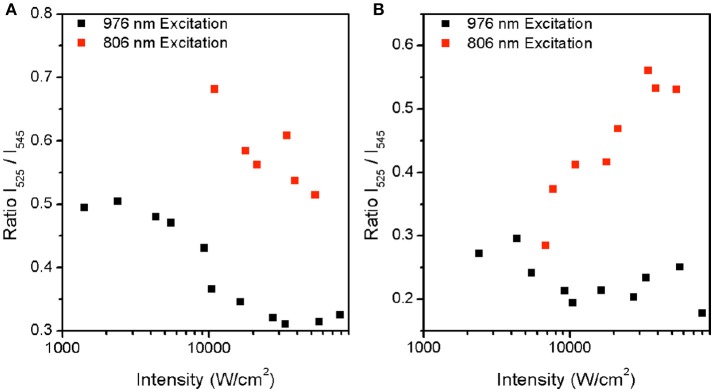
Plot of measured ratio between 2H11/2 and 4S3/2 at increasing intensity for both 806 nm and 976 nm excitation for (A) β-NaYF4:20%Yb, 2% Er (A) and (B) β-NaYF4:40%Yb, 2%Er@NaYF4:20%Yb@NaNdF4:10%Yb.